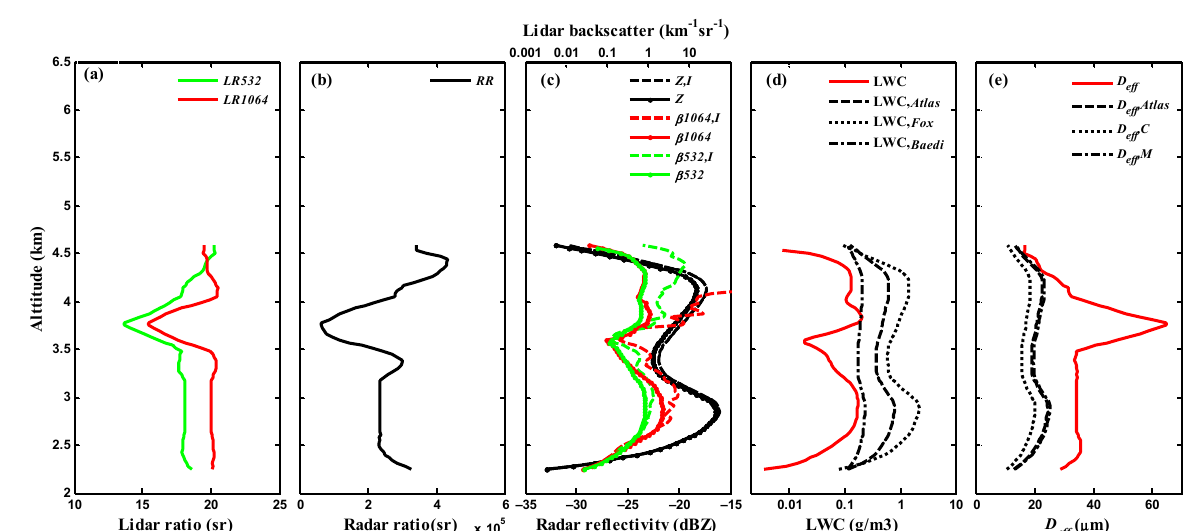
Figure 14. The inversion results at 20:30 p.m. on 16 October 2019: ( a ) lidar ratio at different wavelengths ( LR 532 , LR 1064 ); ( b ) radar ratio ( RR ); ( c ) lidar backscatter at different wavelengths ( β 532 , β 1064 ) and radar reflectivity factor ( Z ) (initial value subscript I ); ( d ) liquid water content (LWC); ( e ) effective diameter ( D eff ).